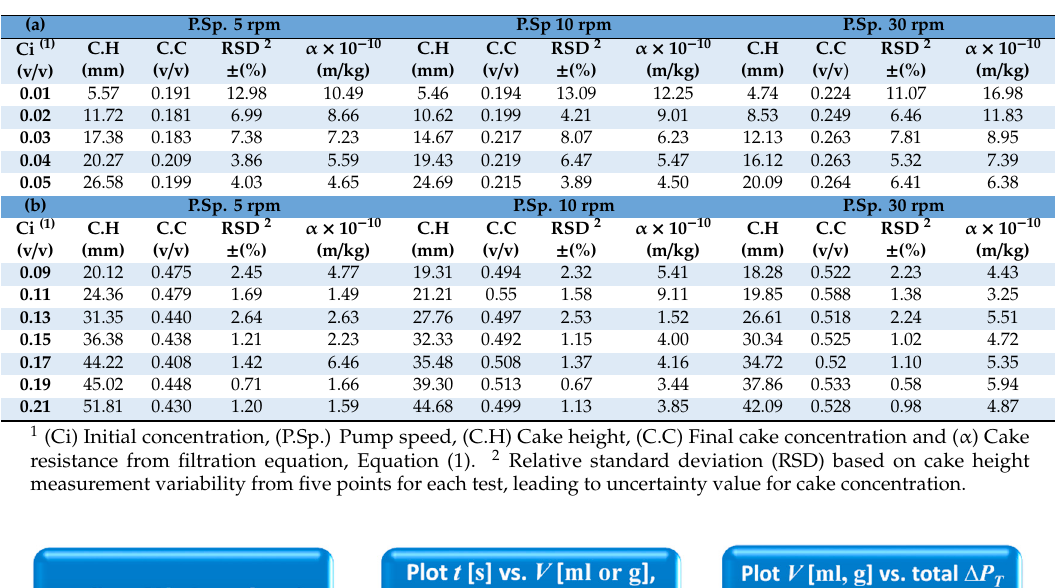
Table 3. Test results for the different initial solid concentration suspensions and various pump suction of both solids: (a) talc and (b) calcium carbonate.